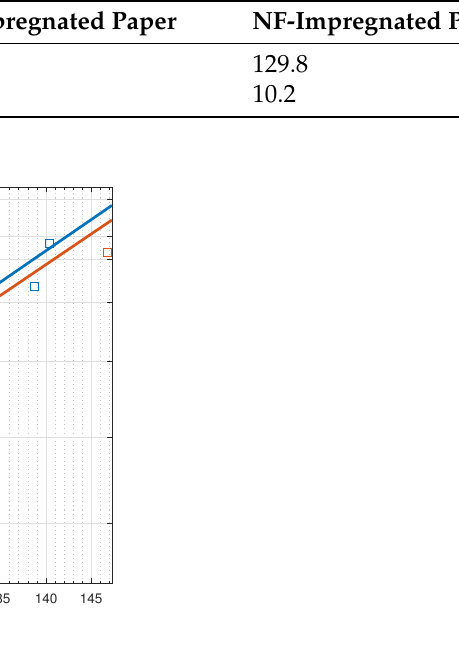
Figure 12. Weibull distribution of the impulse measures on NF-impregnated paper and MO- impregnated